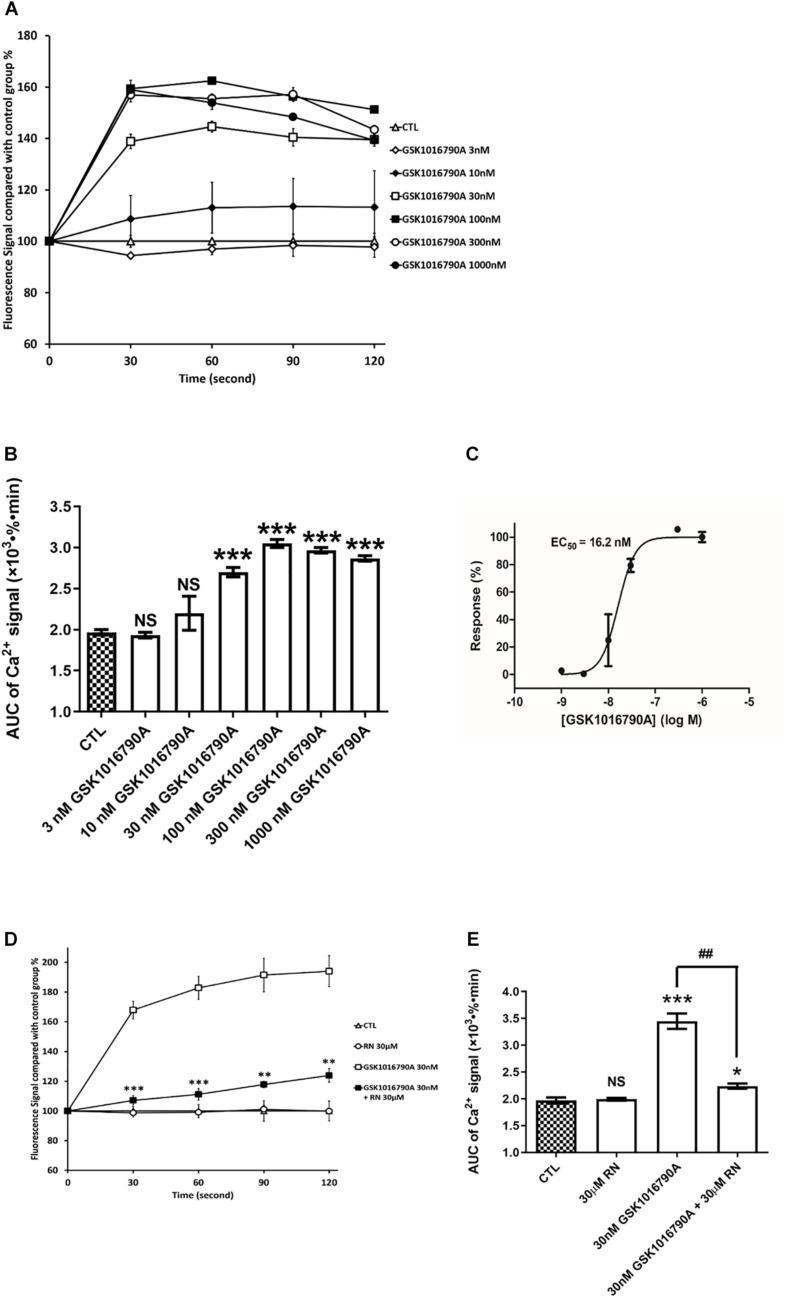
TRPV4 is functional in hCMEC/D3. (A) Representative time course of [Ca2+]i in hCMEC/D3 stimulated by the TRPV4 agonist GSK1016790A. Cells were plated in 24-wells plate and loaded with Fluo-4-AM as described. GSK1016790A was added and the fluorescence was recorded. (B) Change of the area under curve (AUC) over the 120 s obtained from the experiment shown in panel (A). (C) Concentration-response relationship of GSK1016790A. Measurements were obtained from panel (B). (D) Representative time course of [Ca2+]i in hCMEC/D3 stimulated by GSK1016790A and pre-treated or not with the TRPV4 specific antagonist RN1734 (RN). When applying RN, cells were pre-treated with 30 μM RN for 5 min and the fluorescence was recorded in the persistent presence of 30 μM GSK1016790A. (D) Change of the area under curve (AUC) over the 120 s obtained from the experiment shown in panel (C). Data are expressed as mean ± SEM. For panels (B,E), inter-group comparisons were performed by ANOVA with Dunnett a posteriori test, NS, not significant, *p < 0.05, ***p < 0.001 compared with CTL group, ##p < 0.01 compared with 30 nMGSK1016790A group, n = 3 in triplicate. For panel (D), inter-group comparisons were performed by ANOVA with Dunnett a posteriori test, *p < 0.01, **p < 0.01, ***p < 0.001 compared with GSK1016790A group.